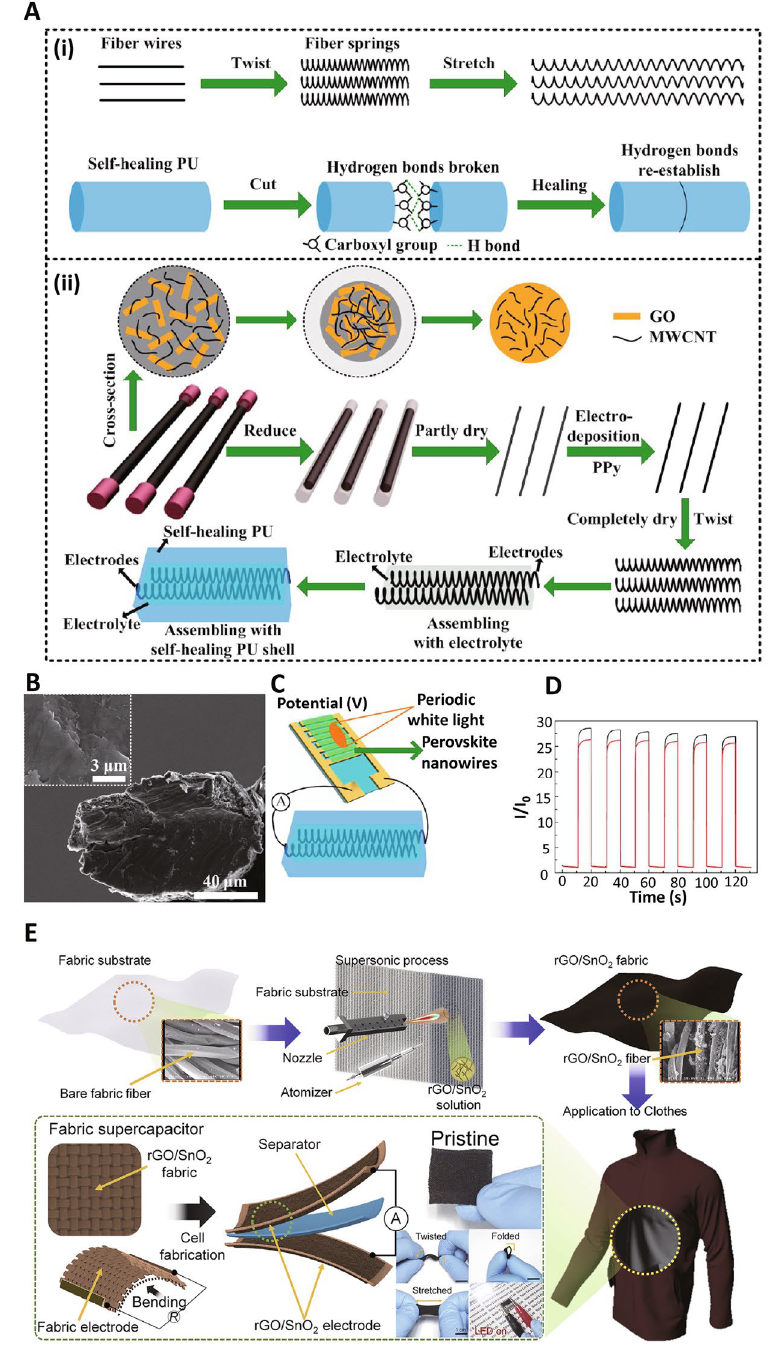
Fig. 9 A Schematic illustration of the self-healable mechanism, along with the fabrication procedure of PPy/rGO/MWCNTs electrodes and self-healing supercapacitor. (i ) rGO-based fiber wires can be twisted to springs. ( ii ) rGO/MWCNTs-based solution was added into pipes; then, rGO/MWCNTs composite fibers were formed. B SEM images of rGO fiber with the size of 100 μm and stacked morphology. C Schematic of the supercapacitor driving a detector of perovskite nanowires. D Photocurrent dependence on the time of the detector under illumination arises by the Reproduced with permission from Ref. [111]. Copyright 2017 American Chemical Society. (E) The preparative process of rGO/SnO2- containing droplets onto a fabric. Reproduced with permission from Ref. [112]. Copyright, 2021 Elsevierself-healing supercapacitor after a heal- ing